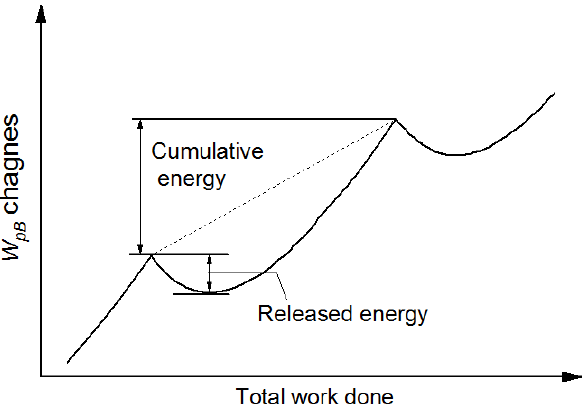
Figure 11. Schematic cumulative and released plastic work of back stress changes during one half cycle of completely reversed strain.